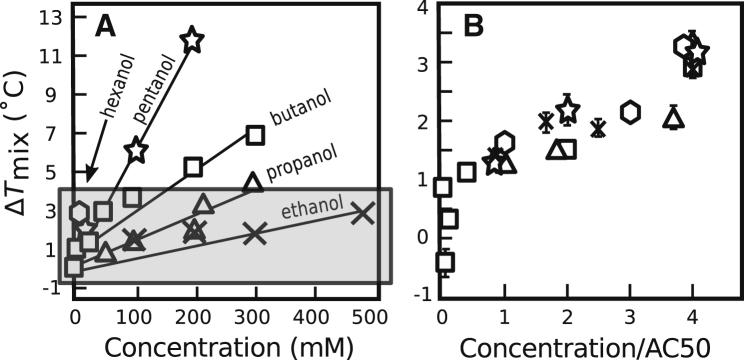
(A) Increases in miscibility transition temperatures of 35/35/30 DOPC/DPPC/cholesterol vesicles scale with the concentration of n-alcohol in the aqueous solution. Lines are least square fits. (B) Data from the shaded region in (A) are rescaled by AC50 values from (14). Because AC50 values are reported to be proportional to partition coefficients of n-alcohols from water into PC bilayers (39), concentration/AC50 should be proportional to the concentration of n-alcohol in the membrane. Each point represents a single experiment for which symbols are typically larger than uncertainties, determined as in Fig. 1. SDs for repeated experiments are typically ± 0.5°C. Fig. 1 data are not replotted here.